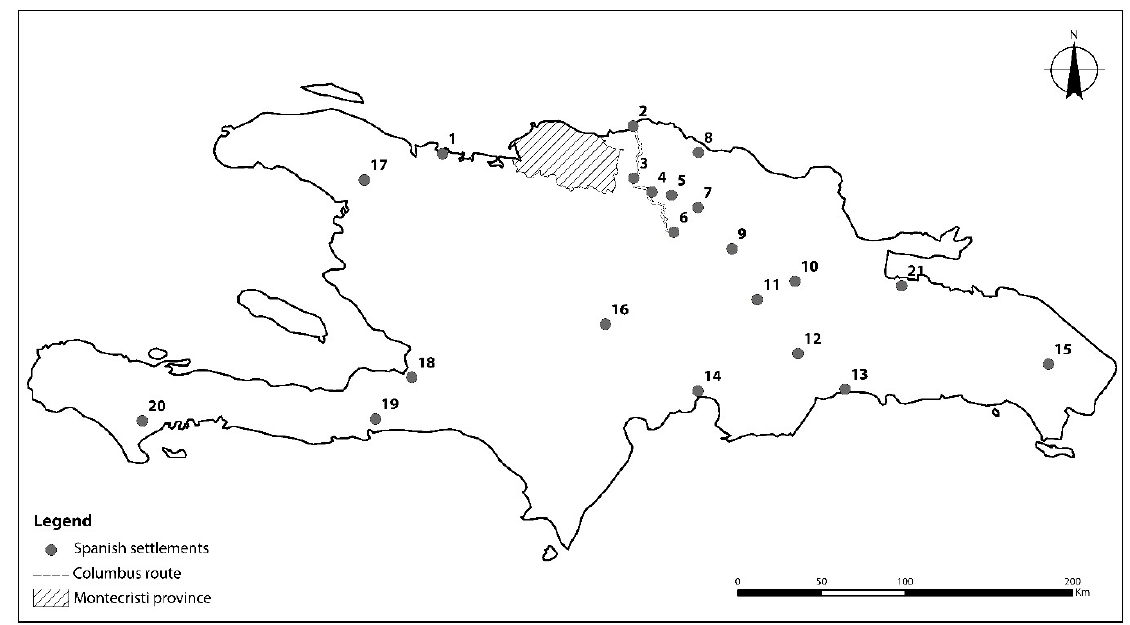
Figure 7. Distributions of early Spanish